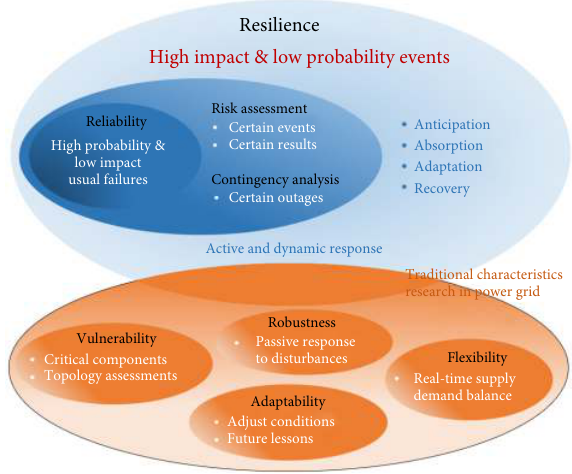
Fig. 2 The characteristics of resilience versus other similar concepts in power